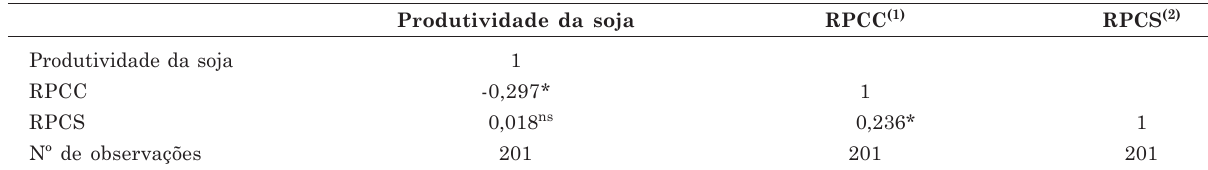
(1) RPCC: resistência do solo à penetração após manejo da cultura de cobertura; (2) RPCS: resistência do solo à penetração depois da colheita da soja; ns não significativo; e * significativo (p<0,05).